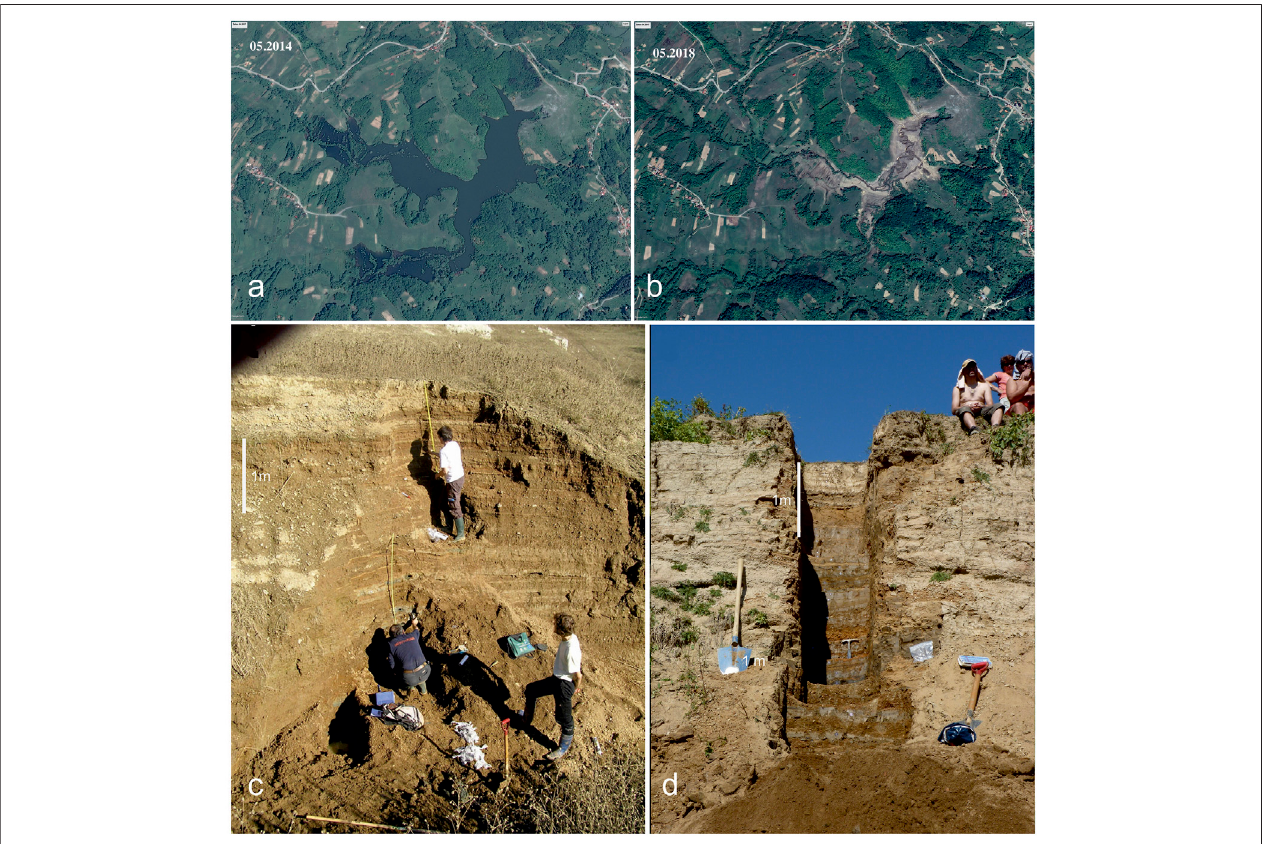
FIGURE2| GoogleEarthimagesofZ ă tonLaketakeninMay2014 (A) andMay2018 (B) ,withandwithoutwater,respectively.Thepicturesshownasfollowswere taken in November 2010 of the Zaton2 pro fi le (C) and in June 2013 of the Zaton3 pro fi le (D) .